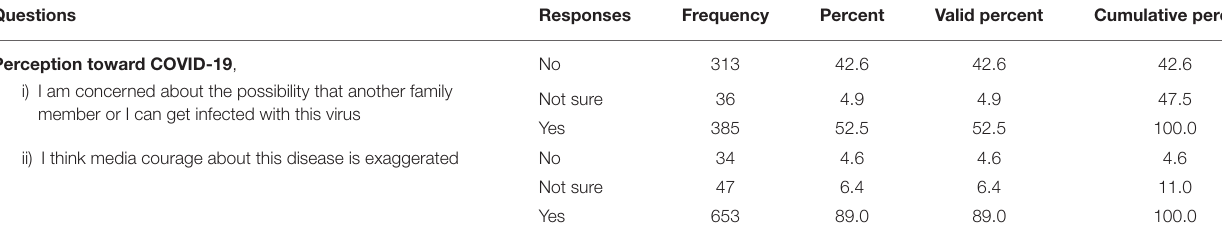
TABLE 4 | Perception toward COVID-19 ( N =